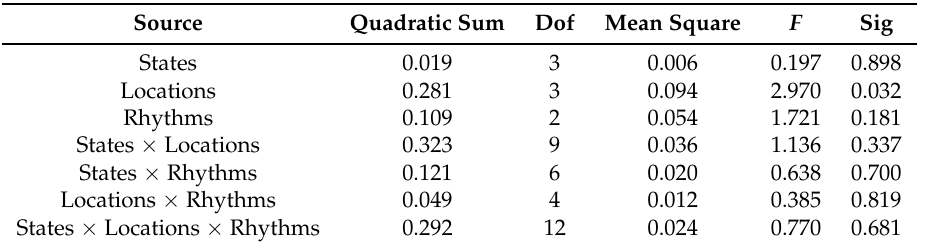
Table 5. MANOVA in the preferred coding method.